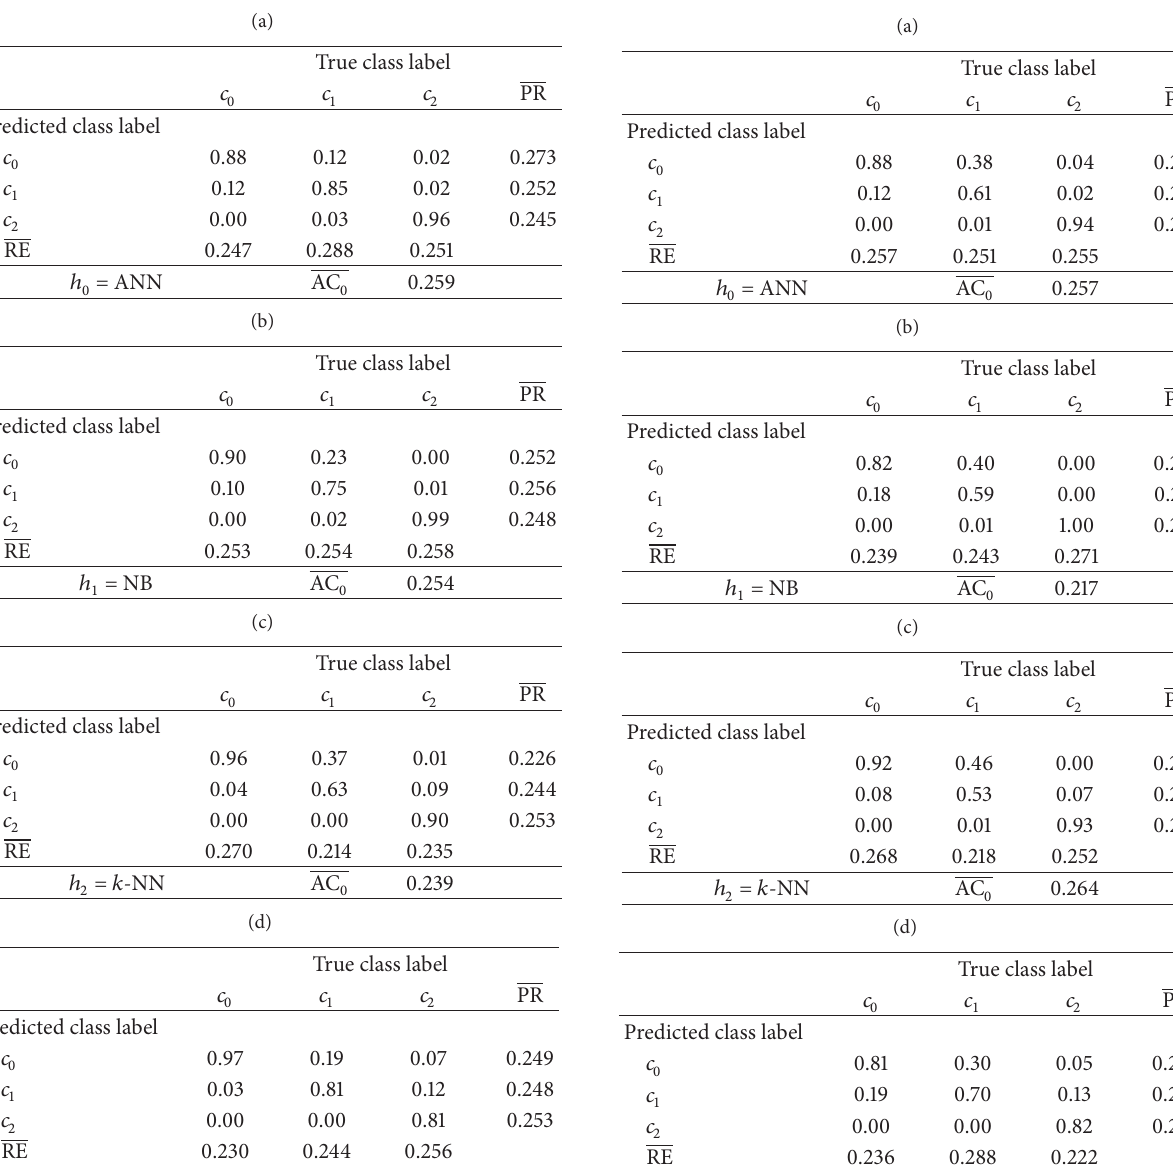
Table 2: Confusion matrix for noiseless data. Table 3: Confusion matrix for noisy data (SNR =